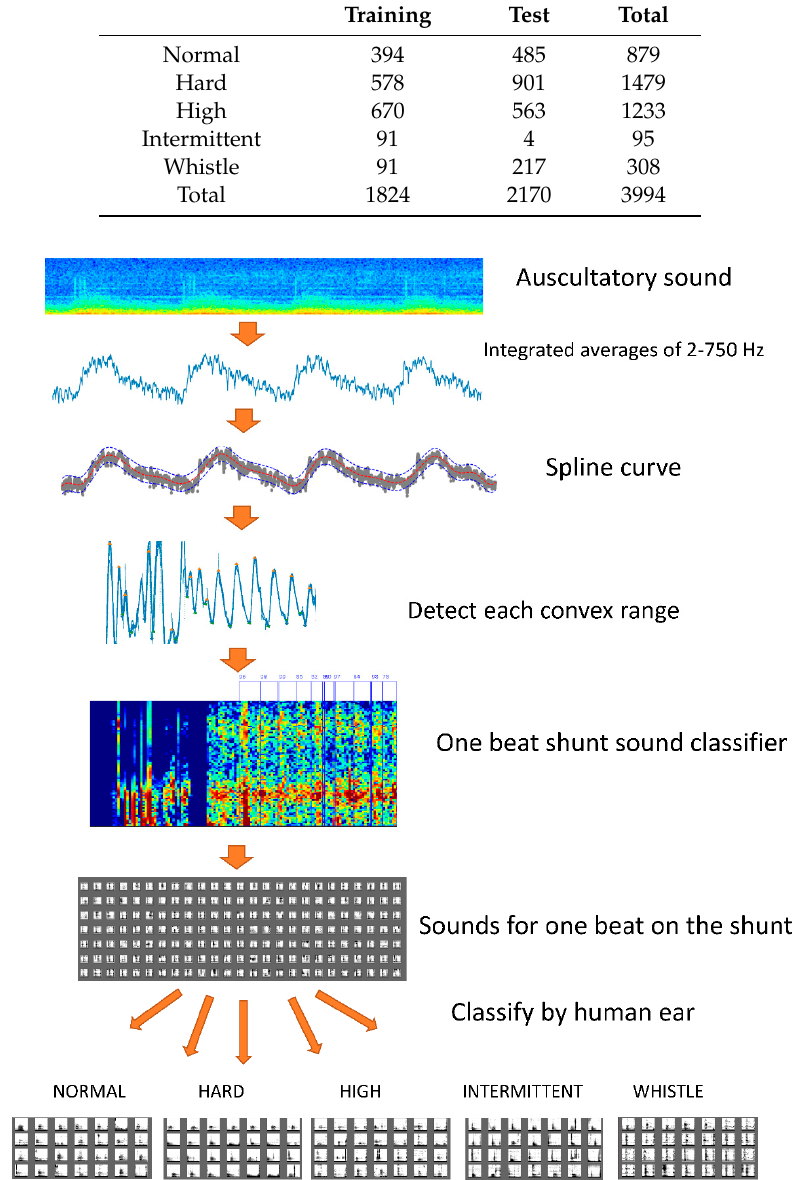
Table 2. Content of the data classified by the human ear and input data used for learning and training. Training and test data were categorized to avoid similar input data from the same patient.